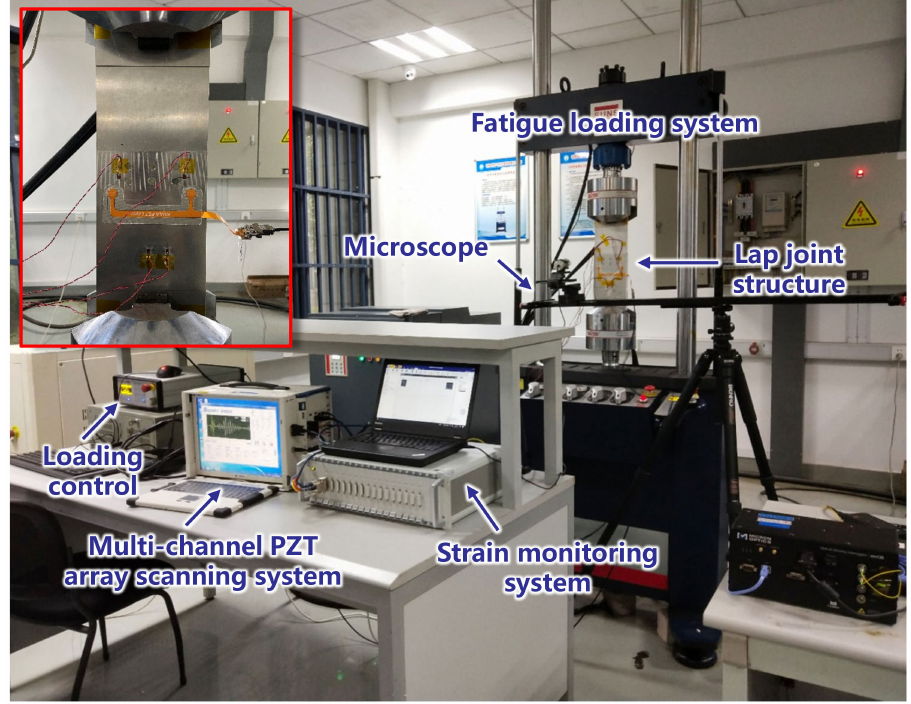
Figure 6. Setup of the fatigue